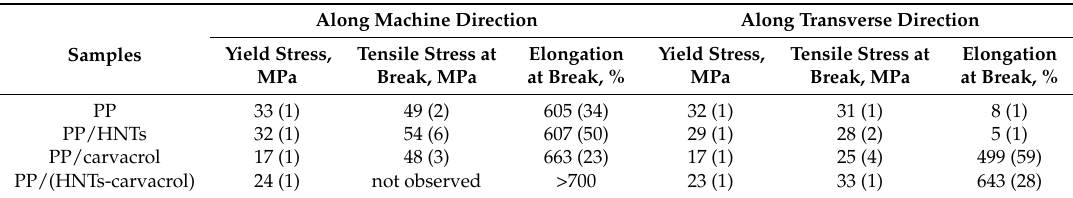
Table 5. Mechanical properties of the films along machine and transverse directions (the numbers in parenthesis indicate standard deviations obtained from at least five repetitions).